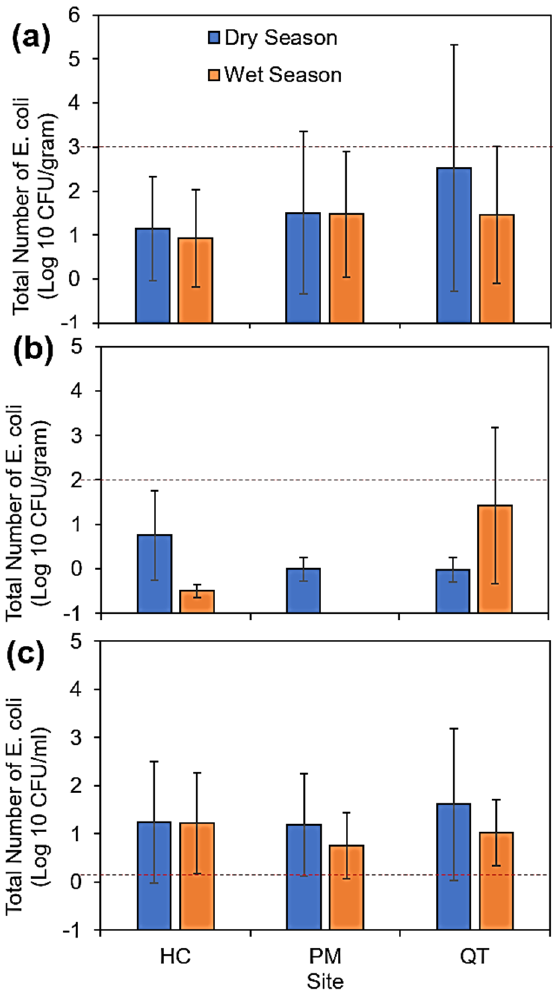
Figure 2. Mean concentrations of E. coli in ( a ) SOL, ( b ) VEG, and ( c ) IRW samples from Huong Chu (HC), Phu Mau (PM), and Quang Thanh (QT) communes. The dotted lines show recommended standards for SOL (US − FDA, 2020) and VEG and IRW (Vietnamese standards) (Ministry of Health, 2012; Ministry of Natural Resources and Environment, 2015). Statistical analysis using Wilcoxon signed-rank test did not show significant differences between the sites and seasons ( p > 0.05).